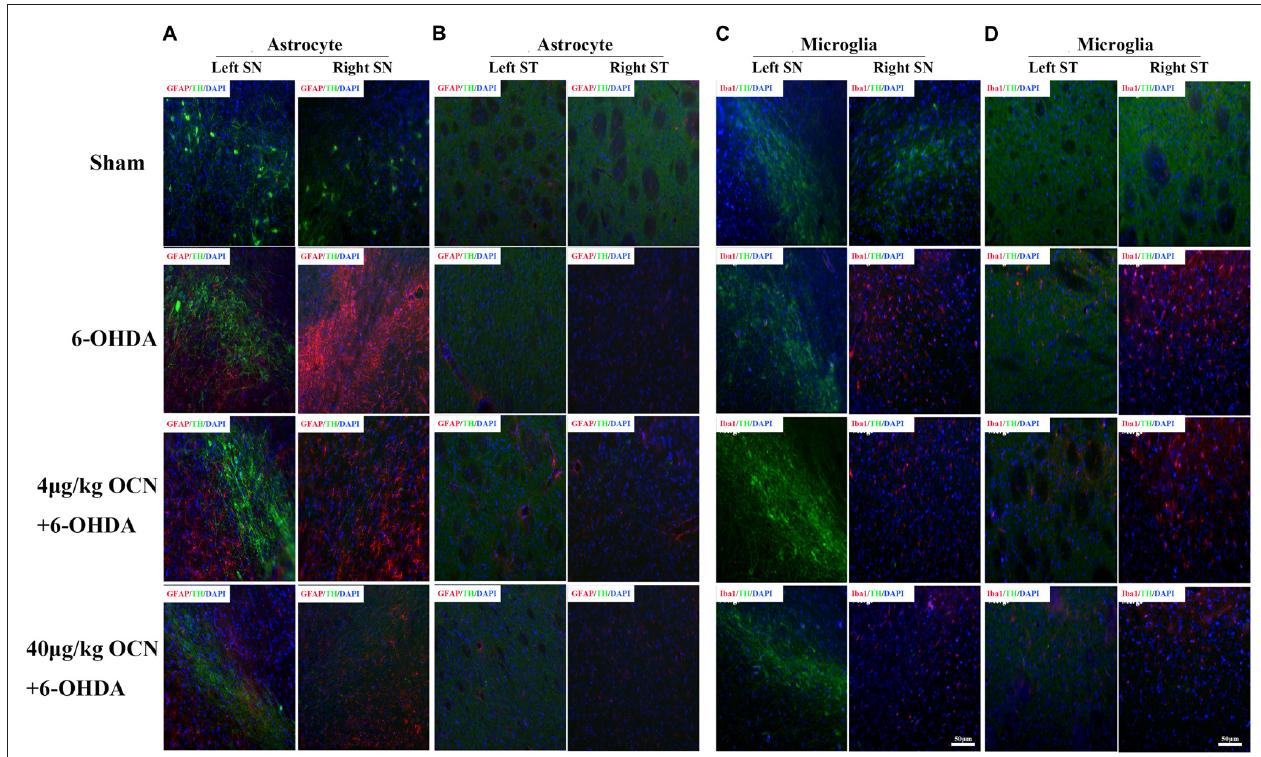
FIGURE 5 | The effect of OCN on the proliferation of astrocytes and microglia. 6-OHDA significantly increased the number of GFAP-positive astrocytes in the lesioned side compared to the intact side both in the SN (A) and striatum (B) , which was inhibited by OCN injection. The same function of OCN on microglial proliferation was also observed, which was stained with Iba1 (C,D) . n = 16. Green = TH, Red = GFAP or Iba1, Blue =